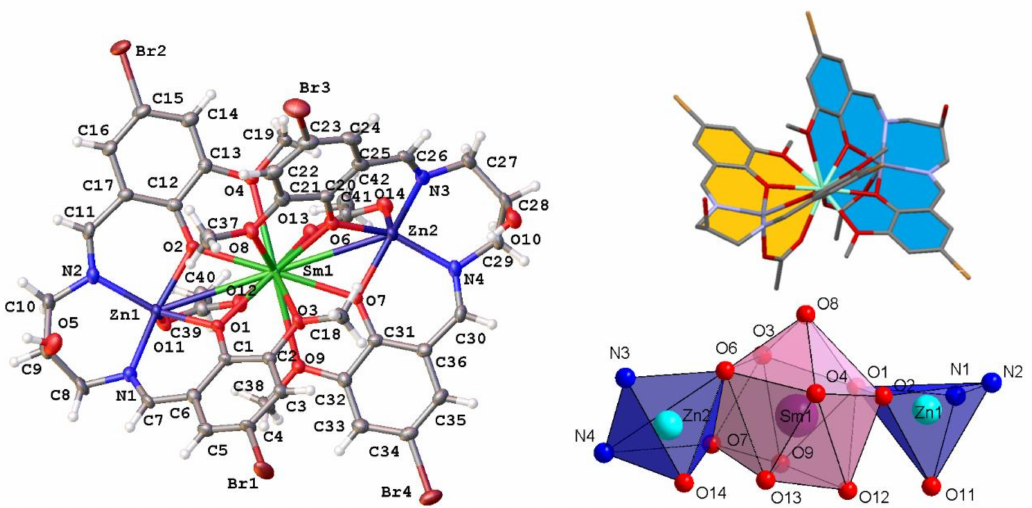
Figure 1. Molecular structure of 2 (Zn II –Sm III –Zn II ) with a propeller molecular shape and coordination polyhedra around the Zn II and Sm III ions. The outer coordination sphere molecules were omitted for clarity.